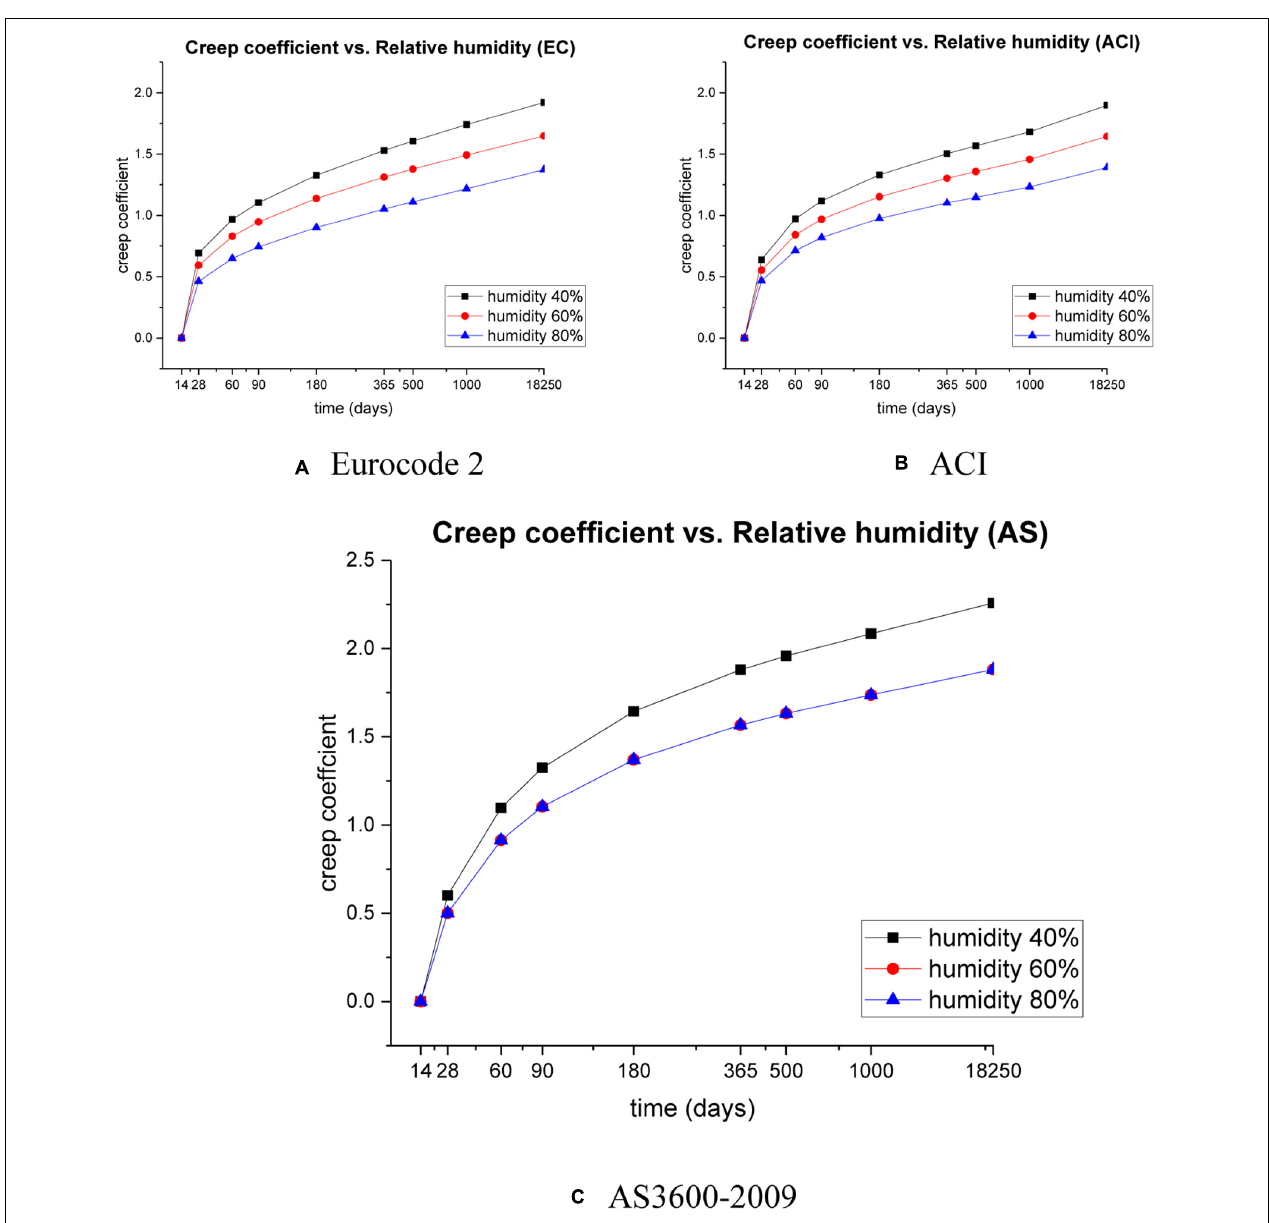
FIGURE 4 | Relative humidity–creep relationship. (A) Euro Code 2, (B) ACI and (C) AS3600-2009.